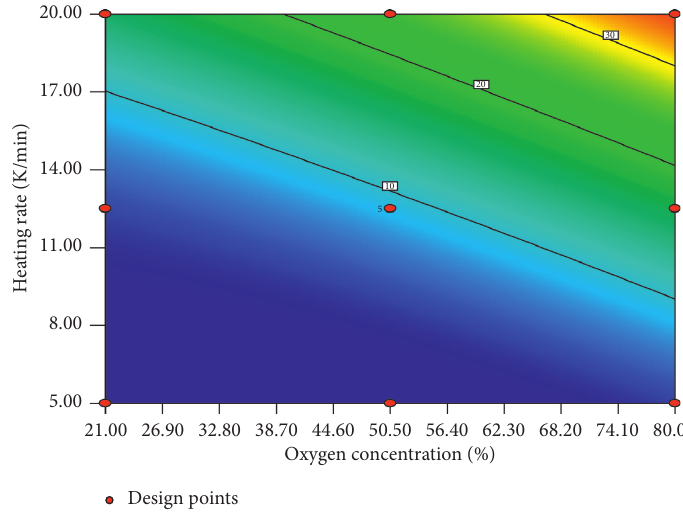
Figure 4: Response surface of comprehensive combustion characteristic index and oxygen. Table 5: The variance of burnout temperature with different models.